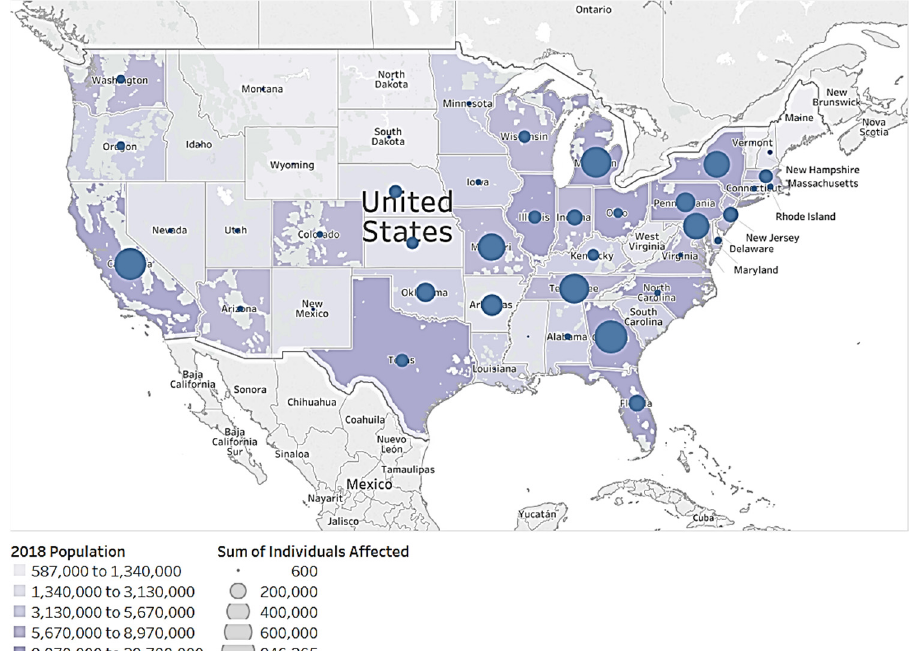
Figure 18. Number of breach records per state.